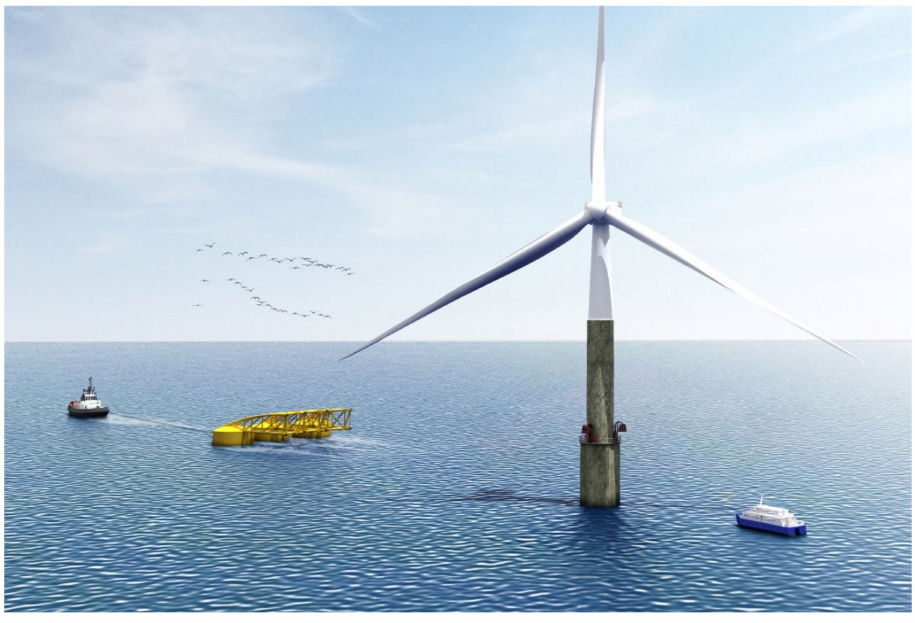
Figure 6. Aerial photo of the Elisa Project, Elican, Arinaga, and Gran Canaria Island [28].